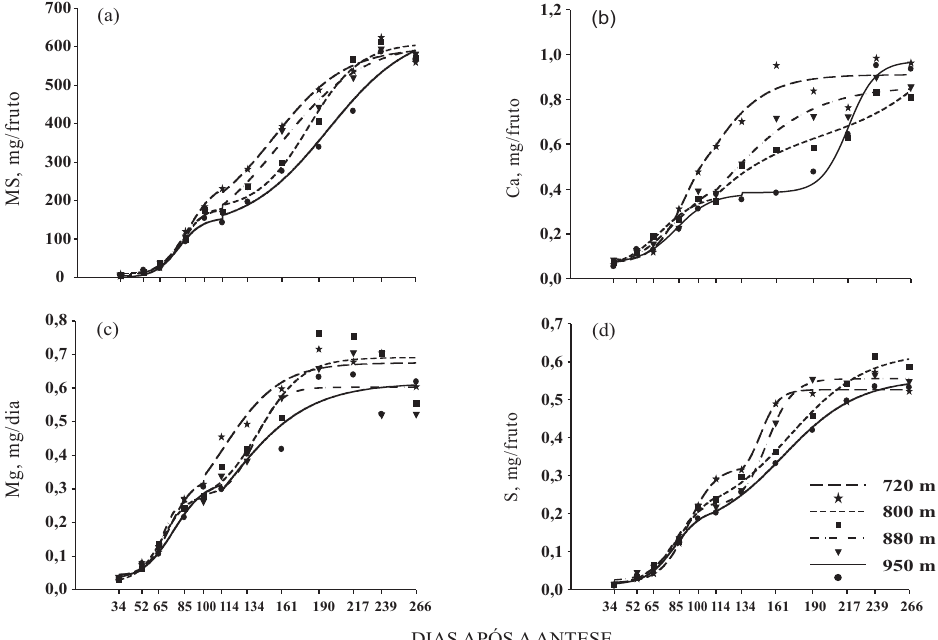
Figura 1. Acúmulo de MS (A), Ca (B), Mg (C) e S (D) em frutos de cafeeiro em função do tempo decorrido após a antese, em quatro